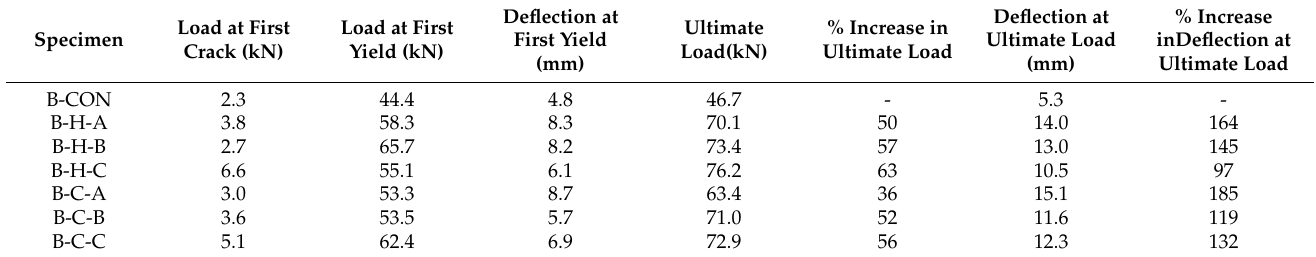
Table 6. Ultimate load and deflection of control and FRRP strengthened RC